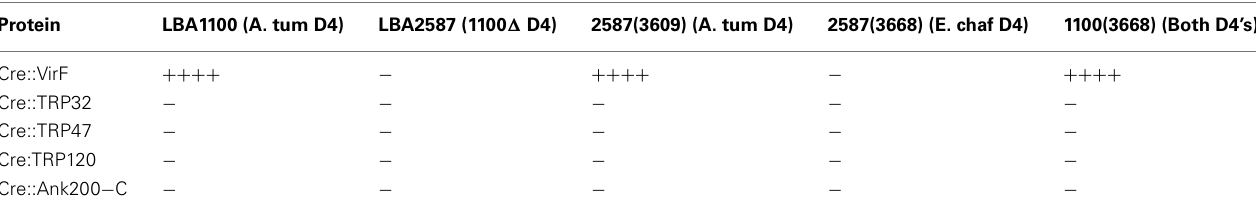
TableA3 | Cre::Vir and Cre:: Ehrlichia protein translocation from A. tumefaciens strain LBA1100 into A. thaliana (CB1), a reporter plant line that allows expression of GFP as a reporter for translocation upon Cre